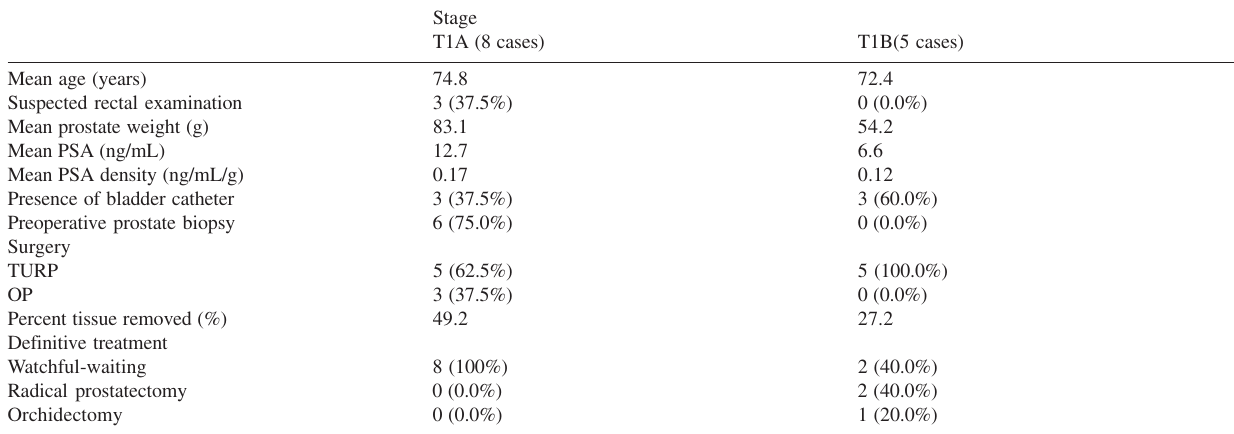
Table 2 - Characteristics of the patients with Characteristics of patients with stage T1b incidental prostate cancer (ICP)